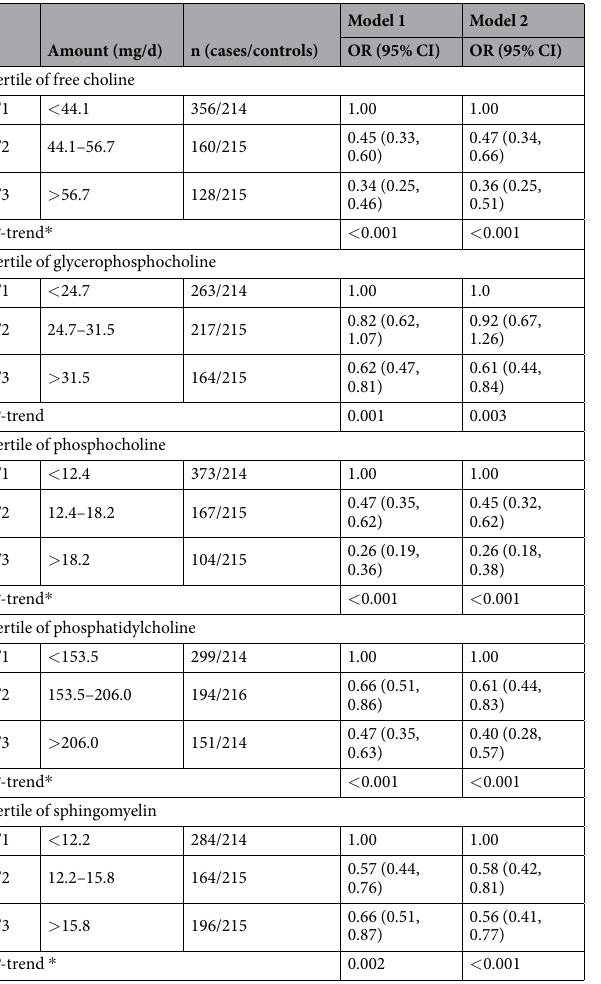
Table 3. Odds ratios (ORs) and 95% confidence intervals (CIs) of primary liver cancer according to the tertiles of the intake of five main choline-containing compounds in all subjects. Models 1 and 2: from the conditional logistic model. Model 1: adjusted for the daily energy intake (ln-transformed), in addition to matching by sex and age. Model 2: Model 1 + , BMI, education level, occupation, household income, smoking, alcohol consumption, tea consumption, physical activity and dietary folate intake. * α for P - trends = 0.05/10(tests) =